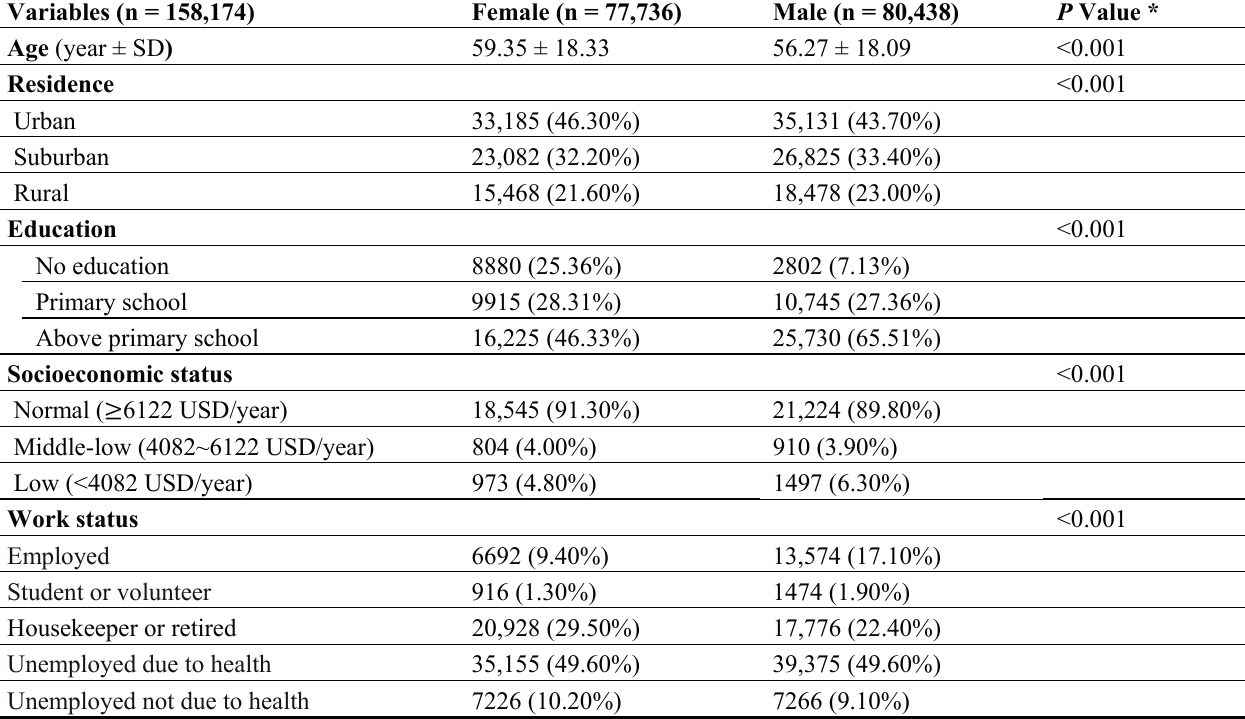
Table 1. Basic characteristics of study